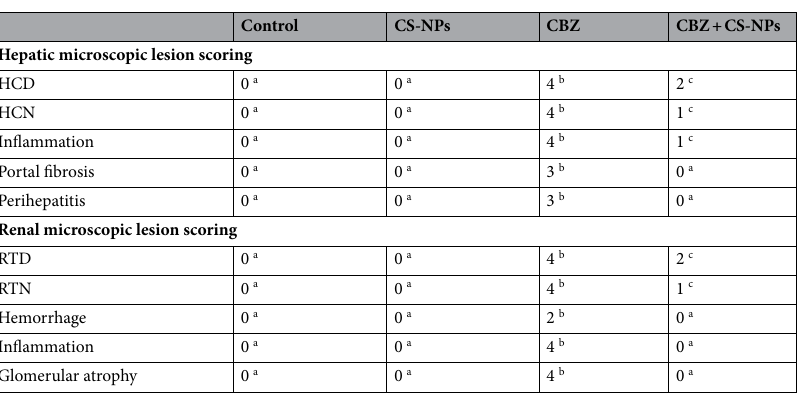
Table 5. The hepatic and renal microscopic lesion scoring in different treatment groups. Values represented as median (n = 7 microscopic field in 5 sections representing 5 rats/group). Different letter at the same row